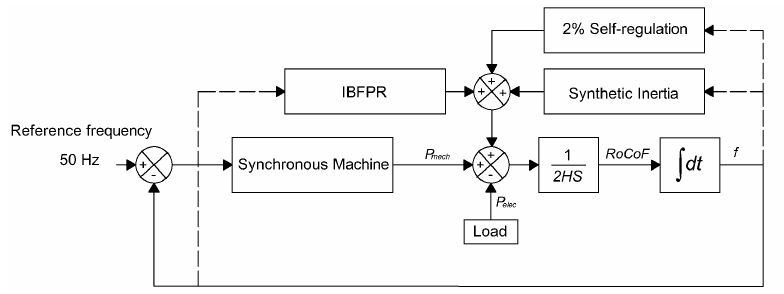
Figure 7. Large scale grid derived from the simplified IEEE